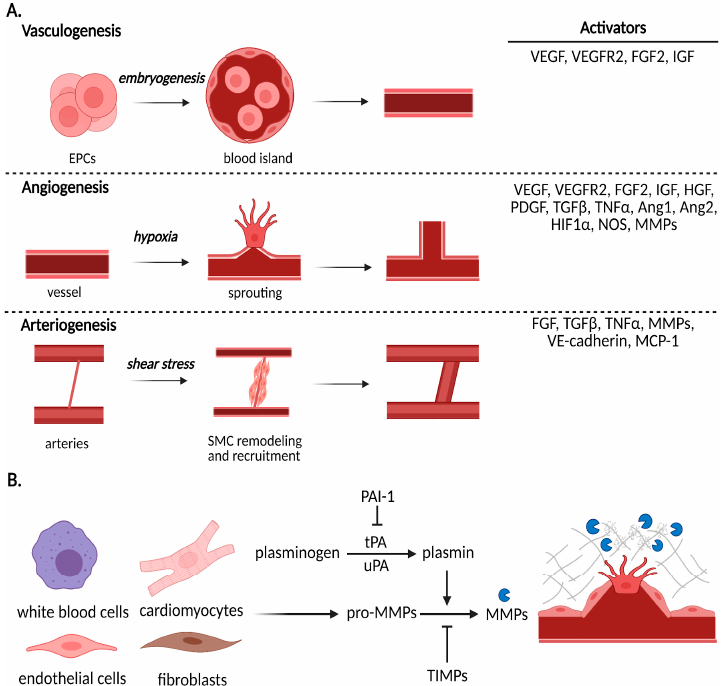
Figure 2. Mechanisms of vascularization and extracellular matrix remodeling. ( A ) Vasculogenesis describes the synthesis of de novo vessels and vasculature that occurs during embryonic development and begins with the differentiation and organization of endothelial progenitor cells. Sprouting angiogenesis is stimulated under hypoxic conditions and is characterized by phalanx, stalk, tip cell migration, proliferation, and tube formation. Arteriogenesis is the process by which shear stress signals for smooth muscle cell recruitment to support an existing vessel between arteries; this vessel then muscularizes to become an established artery. ( B ) An essential process in angiogenesis is extracellular matrix (ECM) remodeling to release growth factor stores from ECM components and promote migration of endothelial cells. A number of cell types contribute to this process in the heart by production of MMPs; their activation is tightly regulated by the plasminogen system and their inhibitors known as tissue inhibitors of metalloproteinases (TIMPs). VEGF, vascular endothelial growth factor; VEGFR2, VEGF receptor 2; FGF2, fibroblast growth factor 2; IGF, insulin growth factor; HGF, hepatocyte growth factor; PDGF, platelet-derived growth factor; TGF β , transforming growth factor β ; TNF α , tumor necrosis factor α ; Ang1, angiopoietin 1; Ang2, angiopoietin 2; HIF1 α , hypoxia inducible factor 1 α ; NOS, nitric oxide synthase; MMPs, matrix metalloproteinases; VE-cadherin; vascular endothelial cadherin; MCP1, monocyte chemoattractant protein